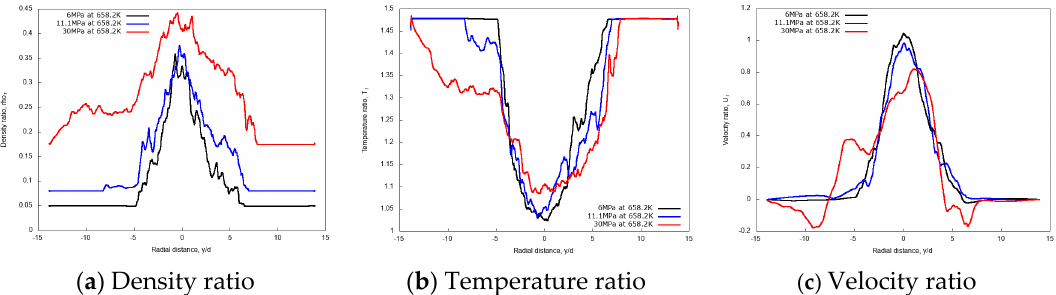
Figure 16. Radial profiles of non-dimensional density, temperature and velocity at fixed axial distance x / d = 20, for different chamber pressures: 6 MPa, 11.1 MPa, and 30 MPa. Simulations of n-dodecane injected at 658.2 K and 200 m/s into nitrogen at 972.9 K.